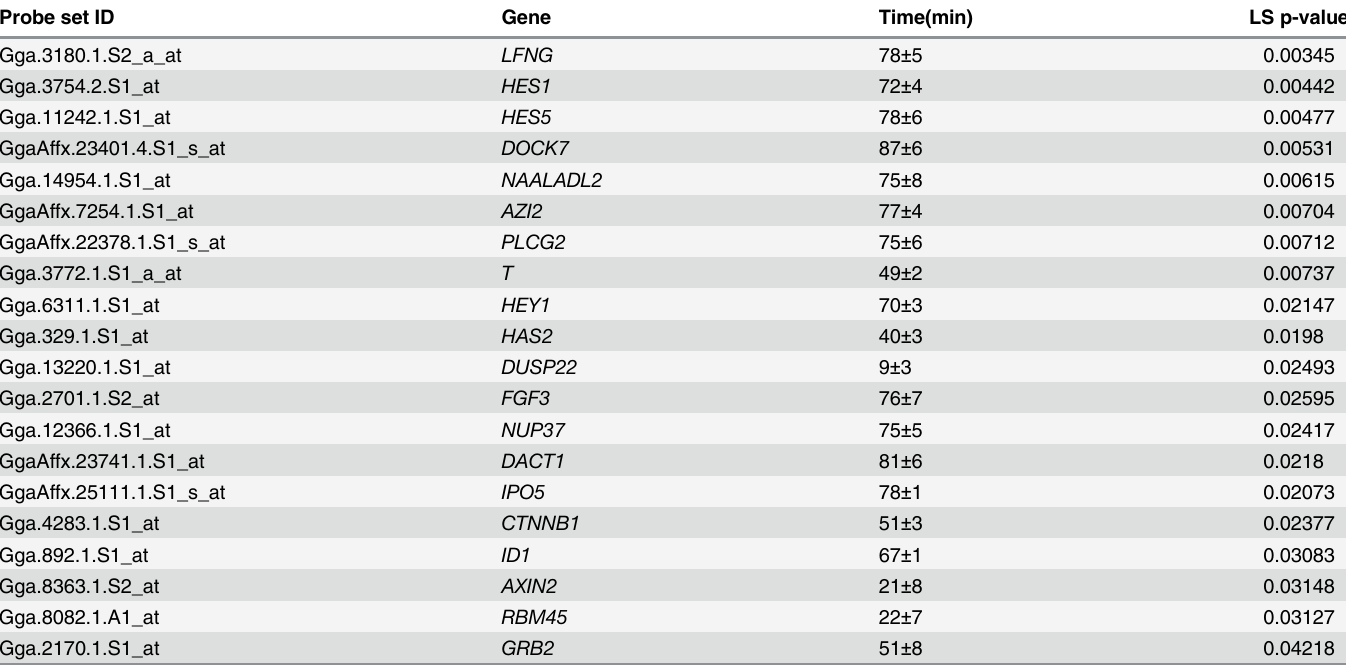
Table 1. Top 20 genes with one peak of expression during chicken somitogenesis. Times in minutes, assuming a 90mn periodicity, are provided for each peak. Accuracy has been estimated using a Monte Carlo method. All experimentally validated cyclic genes were detected using our algorithm (see